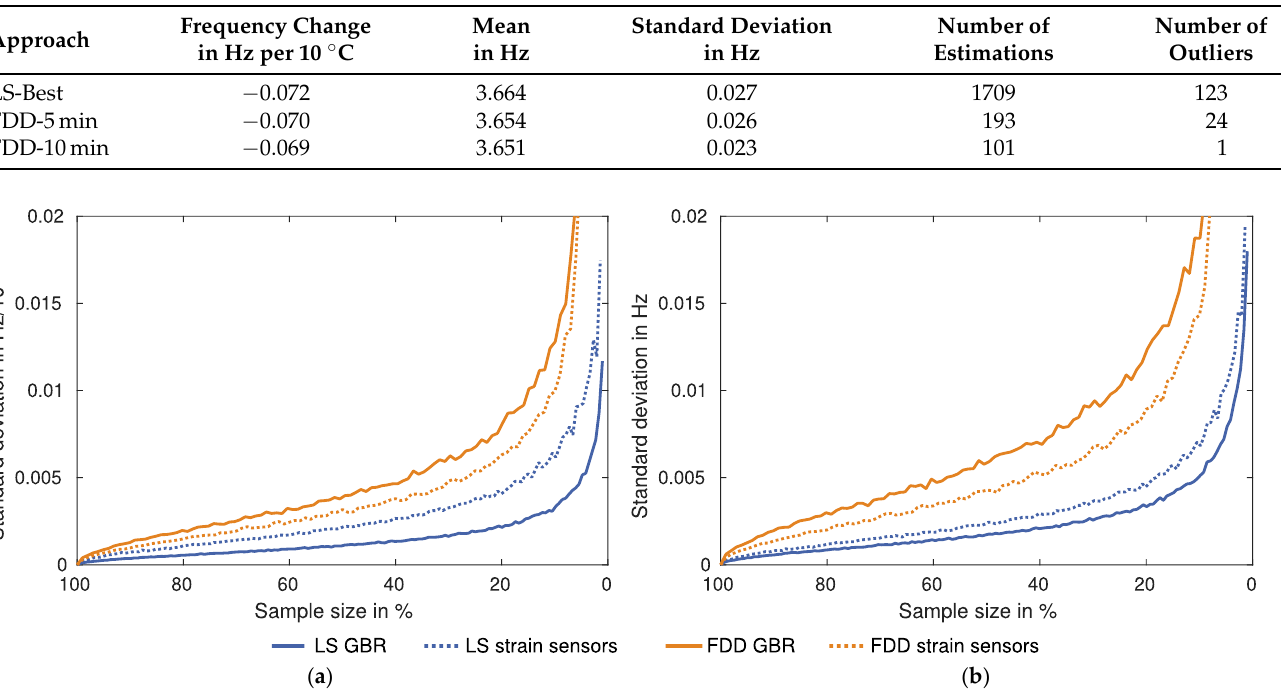
Figure 6. Natural frequencies estimated from GBR measurements by Frequency Domain Decomposi- tion (FDD) with ( a ) a time window of 5min and ( b ) a time window of 10min. Table 4. Comparison of natural frequency estimation for the least squares (LS) approach and FDD with time windows of 5and 10min.